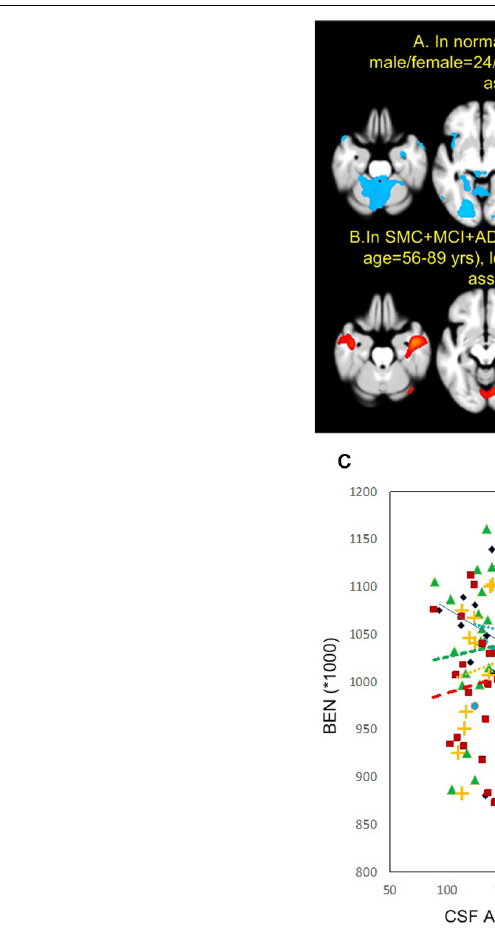
FIGURE 4 | Brain entropy (BEN) vs. cerebrospinal fluid (CSF) A β associations in panel (A) controls and (B) MCI and AD. (C) The associations for each sub-group in precuneus. The red cross in the 4th image in panel (A) indicates the location of the precuneus region of interest. The lines in panel (C) depict the linearly fitted associations. EMCI, early mild cognitive impairment; LMCI, late mild cognitive